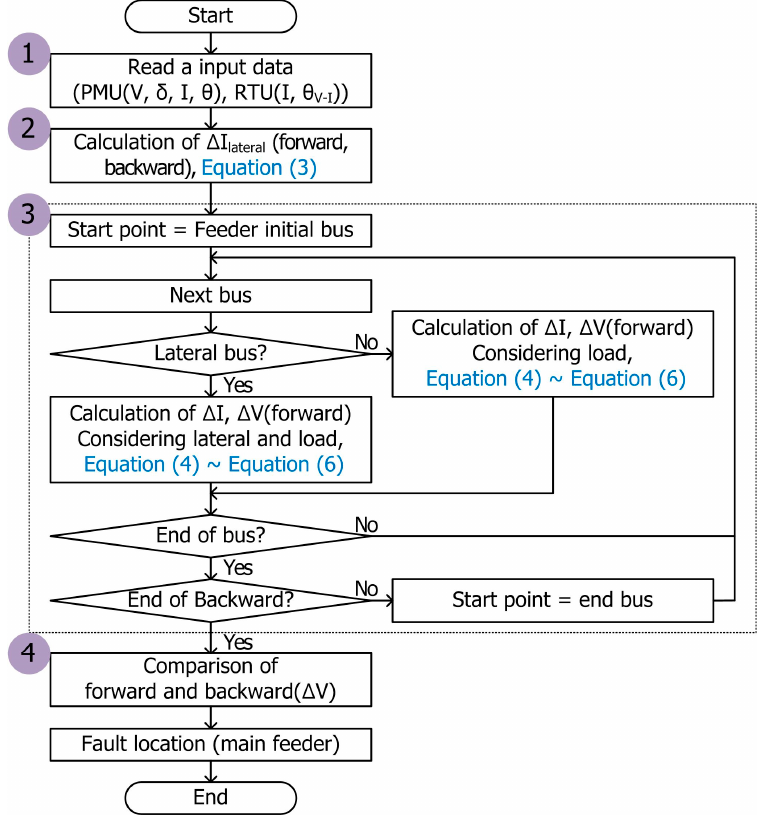
Figure 4. Flowchart of the proposed fault location method (Stage 1).